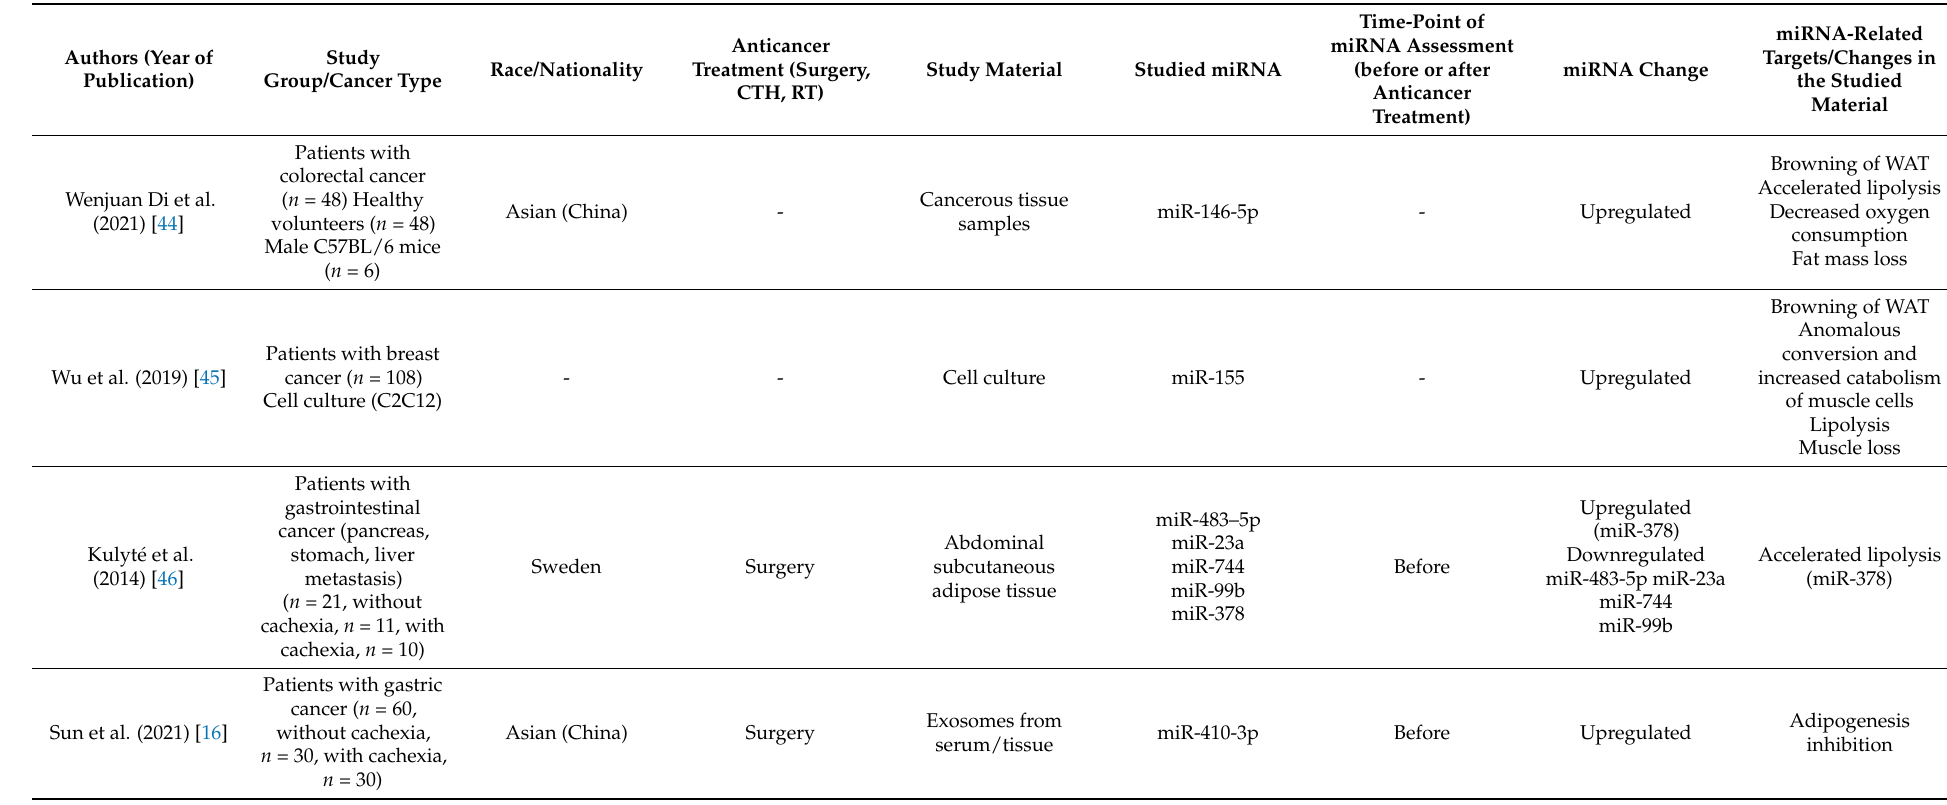
Table 2. The role of miRNAs in cancer cachexia-related adipose tissue